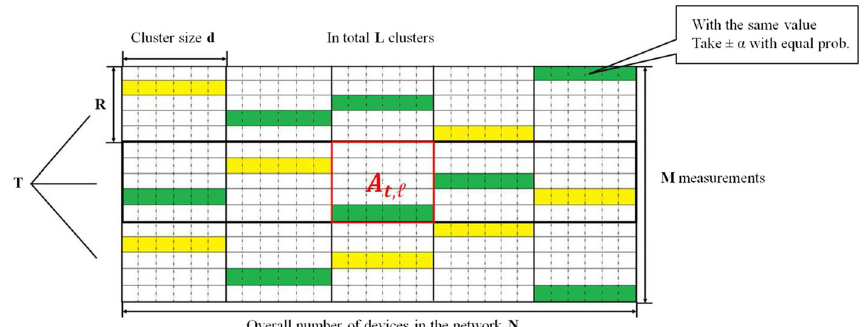
Fig. 2 Structure of the measurement matrix